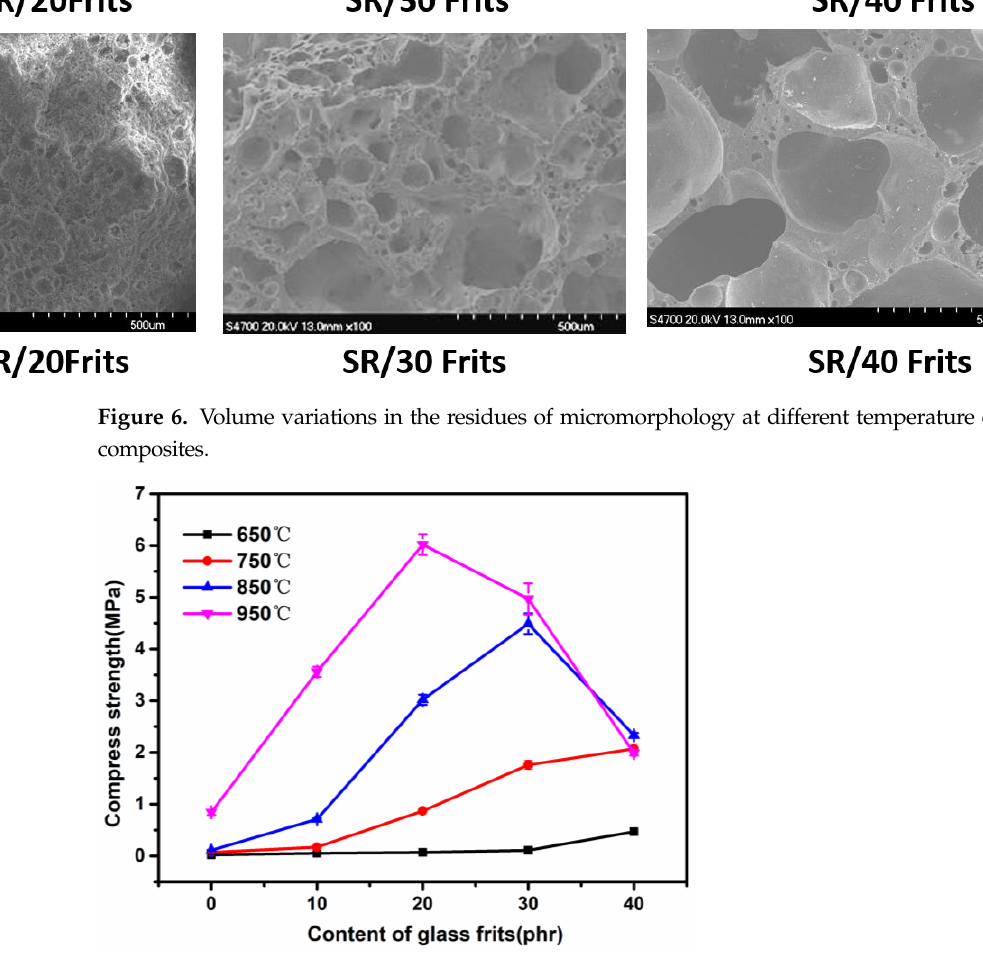
Figure 7. Compression strength of the residues of the silicone composites at different temperatures.